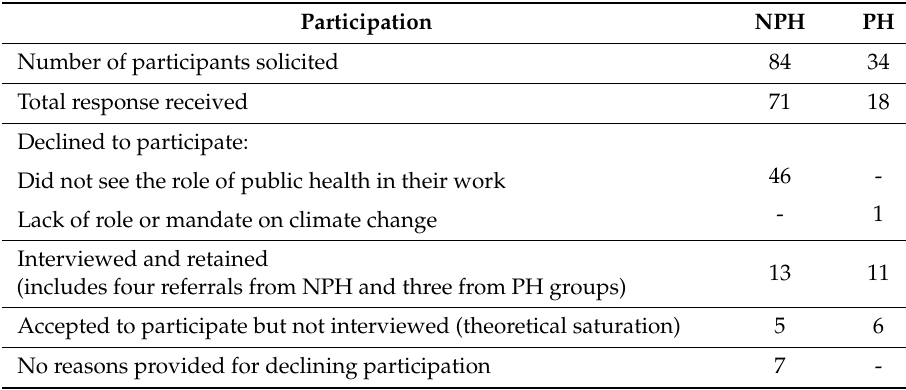
Table 2. Participation solicitation, response, and retention